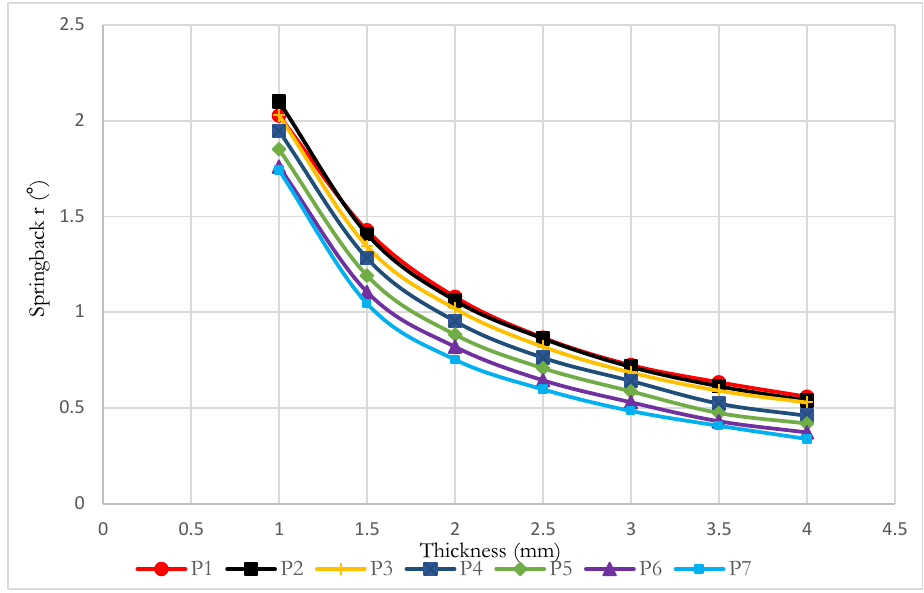
Fig. 9. The evolution of springback (Num.) as a function of thicknesses.